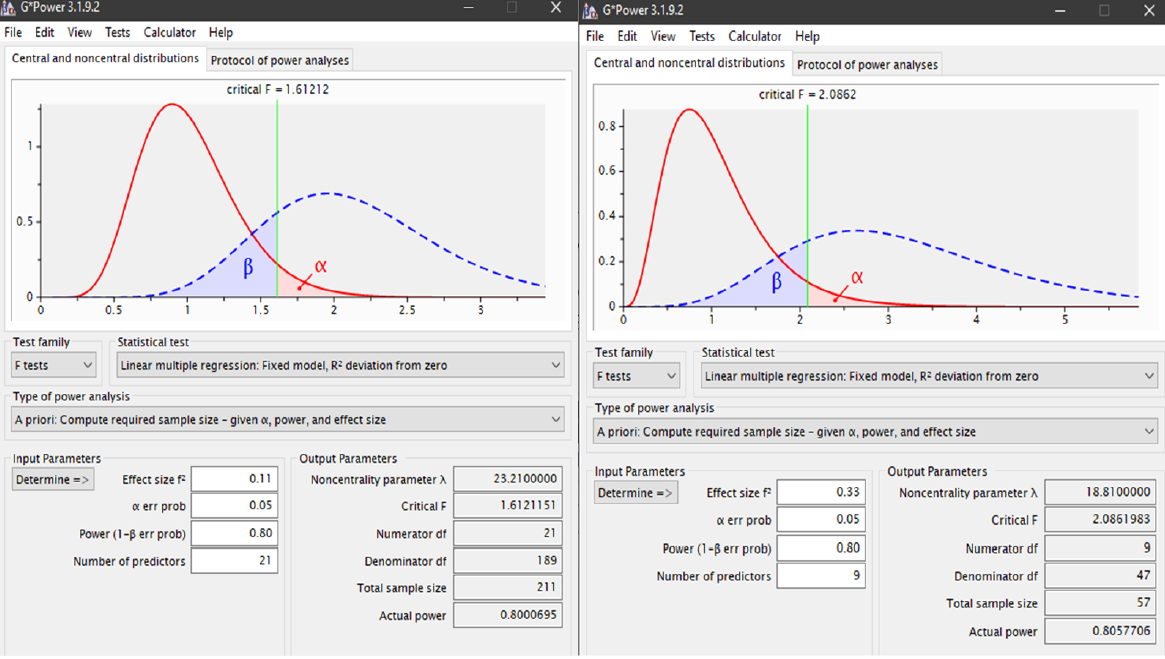
Figure 9. An example of an a priori calculation with